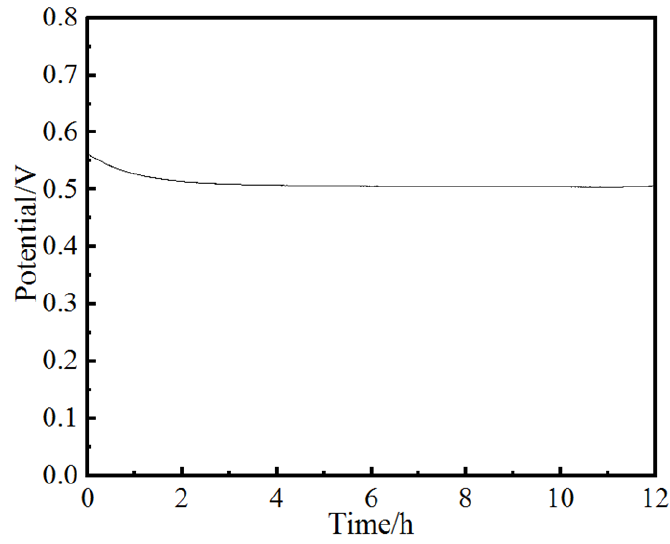
Figure 10. Chronoamperometry test of Ni 4 Co 4 Fe 2 -LDH/NF at 10 mA · cm − 2 .